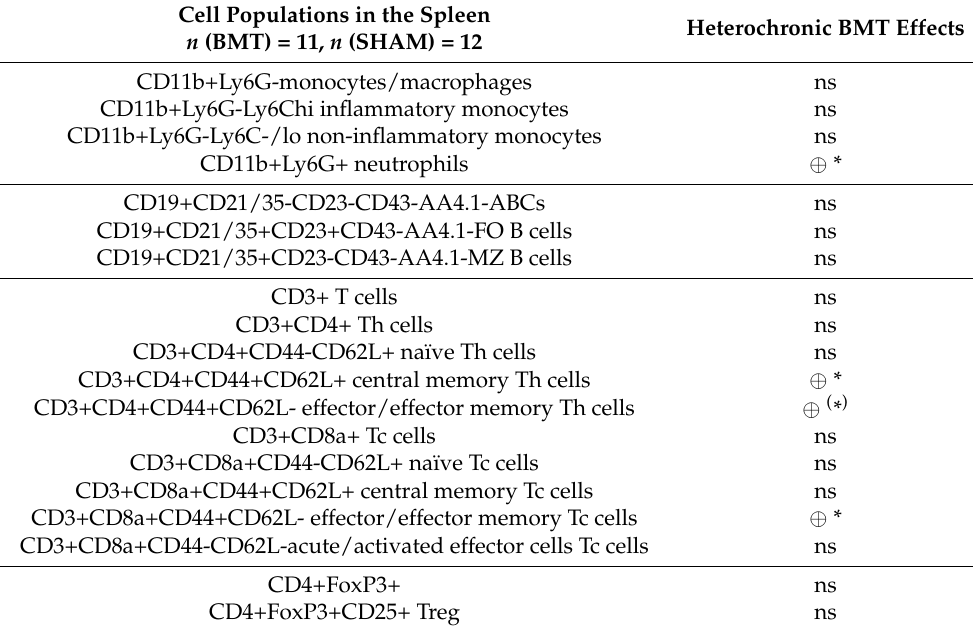
Table 1. Immunophenotyping by flow cytometry (cell source: spleen). Cell Populations in the Spleen